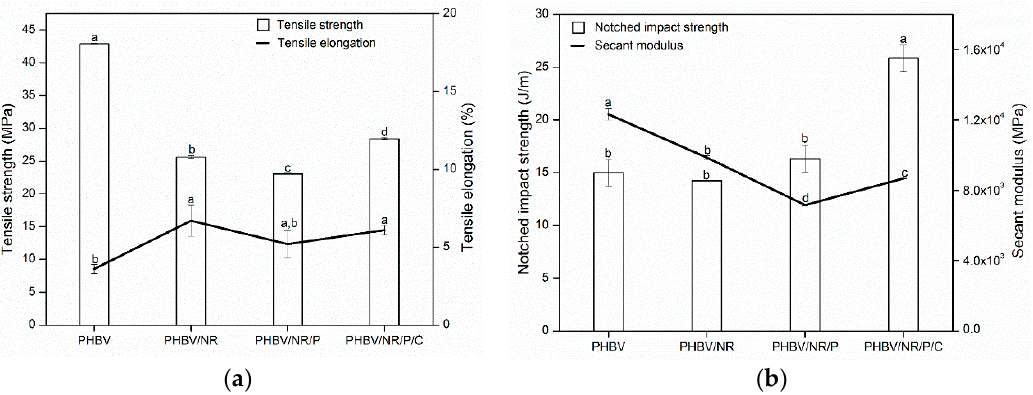
Figure 4. Mechanical properties of PHBV and the blends with NR. (Means showing different letters are significantly different at α = 0.05.)